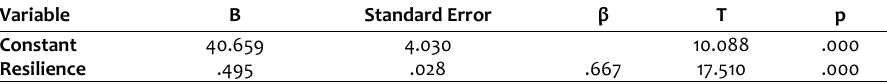
Table 20. Results of Simple Linear Regression Analysis Regarding Prediction of Mathematical Skills of the 5- Year-Old Preschoolers Variable B Standard Error β T p Constant 40.659